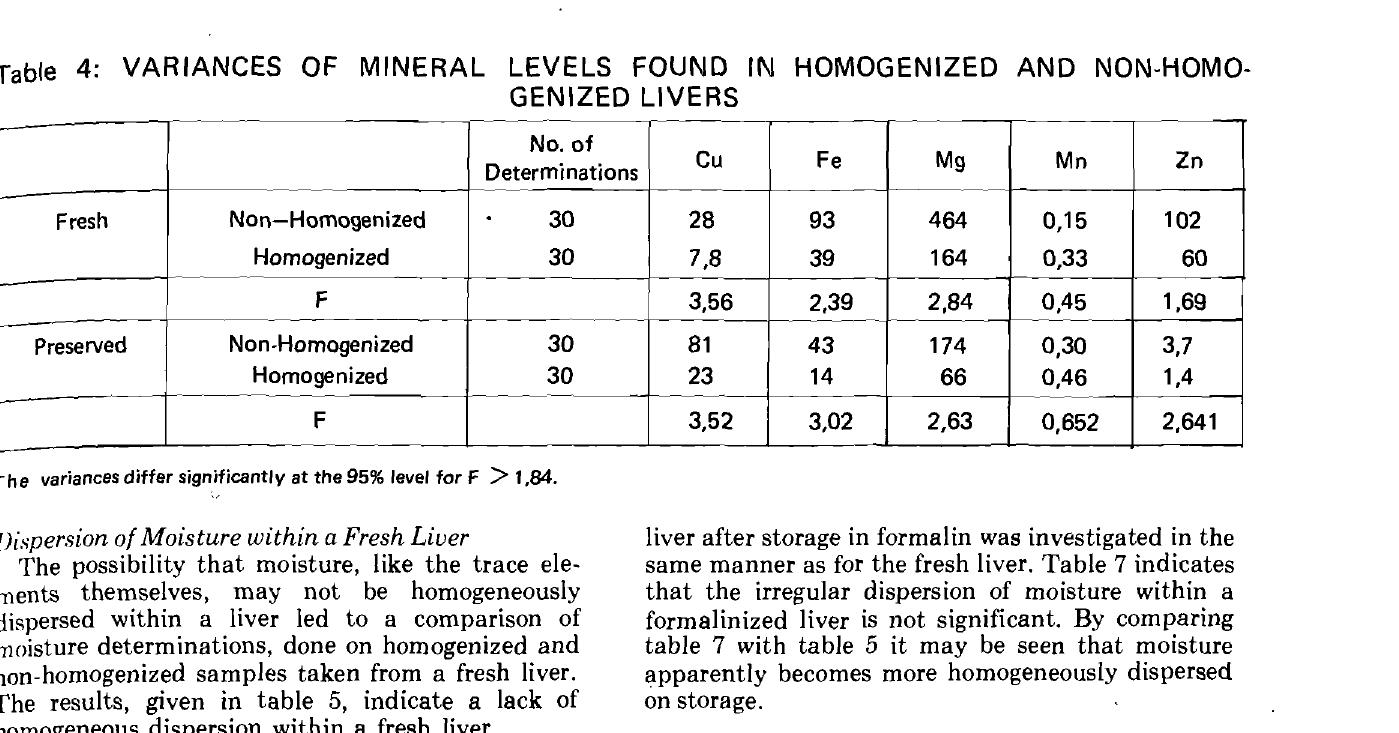
that the irregular dispersion of moisture within a apparently becomes more homogeneously dispersed Table 7: MOISTURE DISPERSION IN A FOR Table 5: DISPERSION OF MOISTURE WITHIN A FRESH LIVER Non-Homogenized